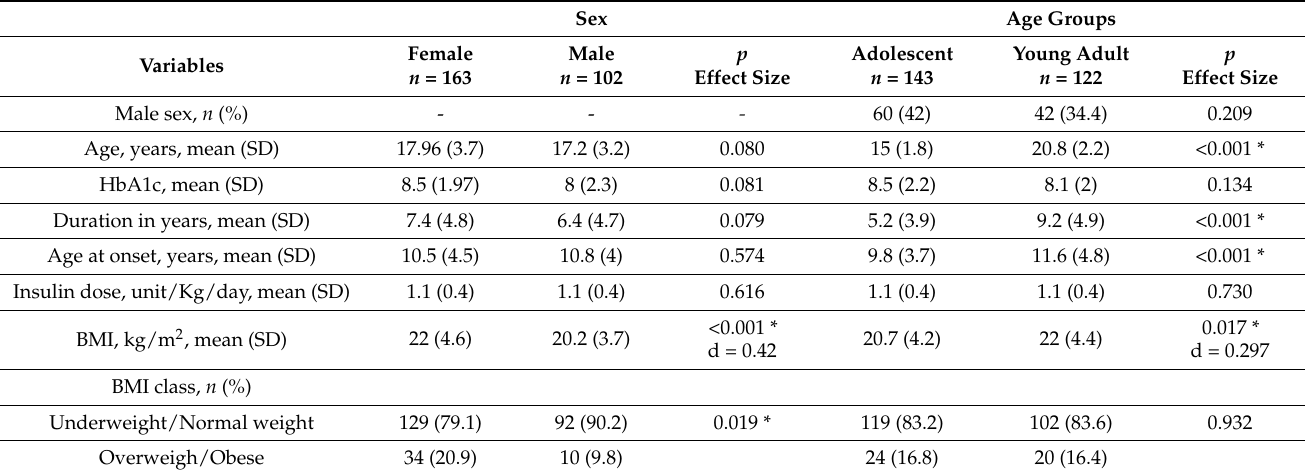
Table 1. Demographic and clinical characteristics grouped by gender and